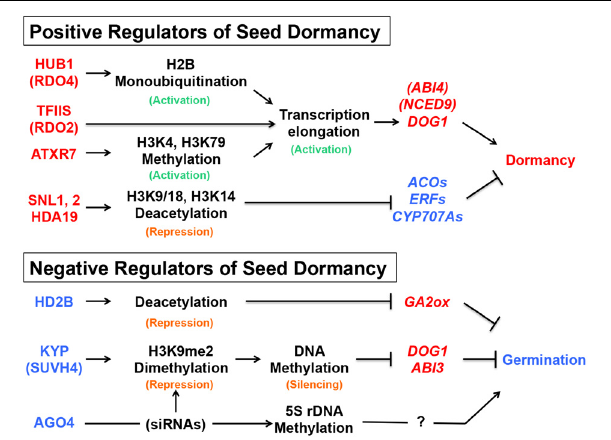
FIGURE 5 | Summary of the seed dormancy or germination pathways described in this article. The positive (red) and negative (blue) regulators of seed dormancy and their roles in the chromatin remodeling, DNA modification or siRNA pathways are indicated, together with promotive (arrows) or suppressive (blocked arrows) effects on the downstream genes (italics). Active (green) or repressive (orange) marks on histones or DNA are also indicated. See text for gene and protein symbols and